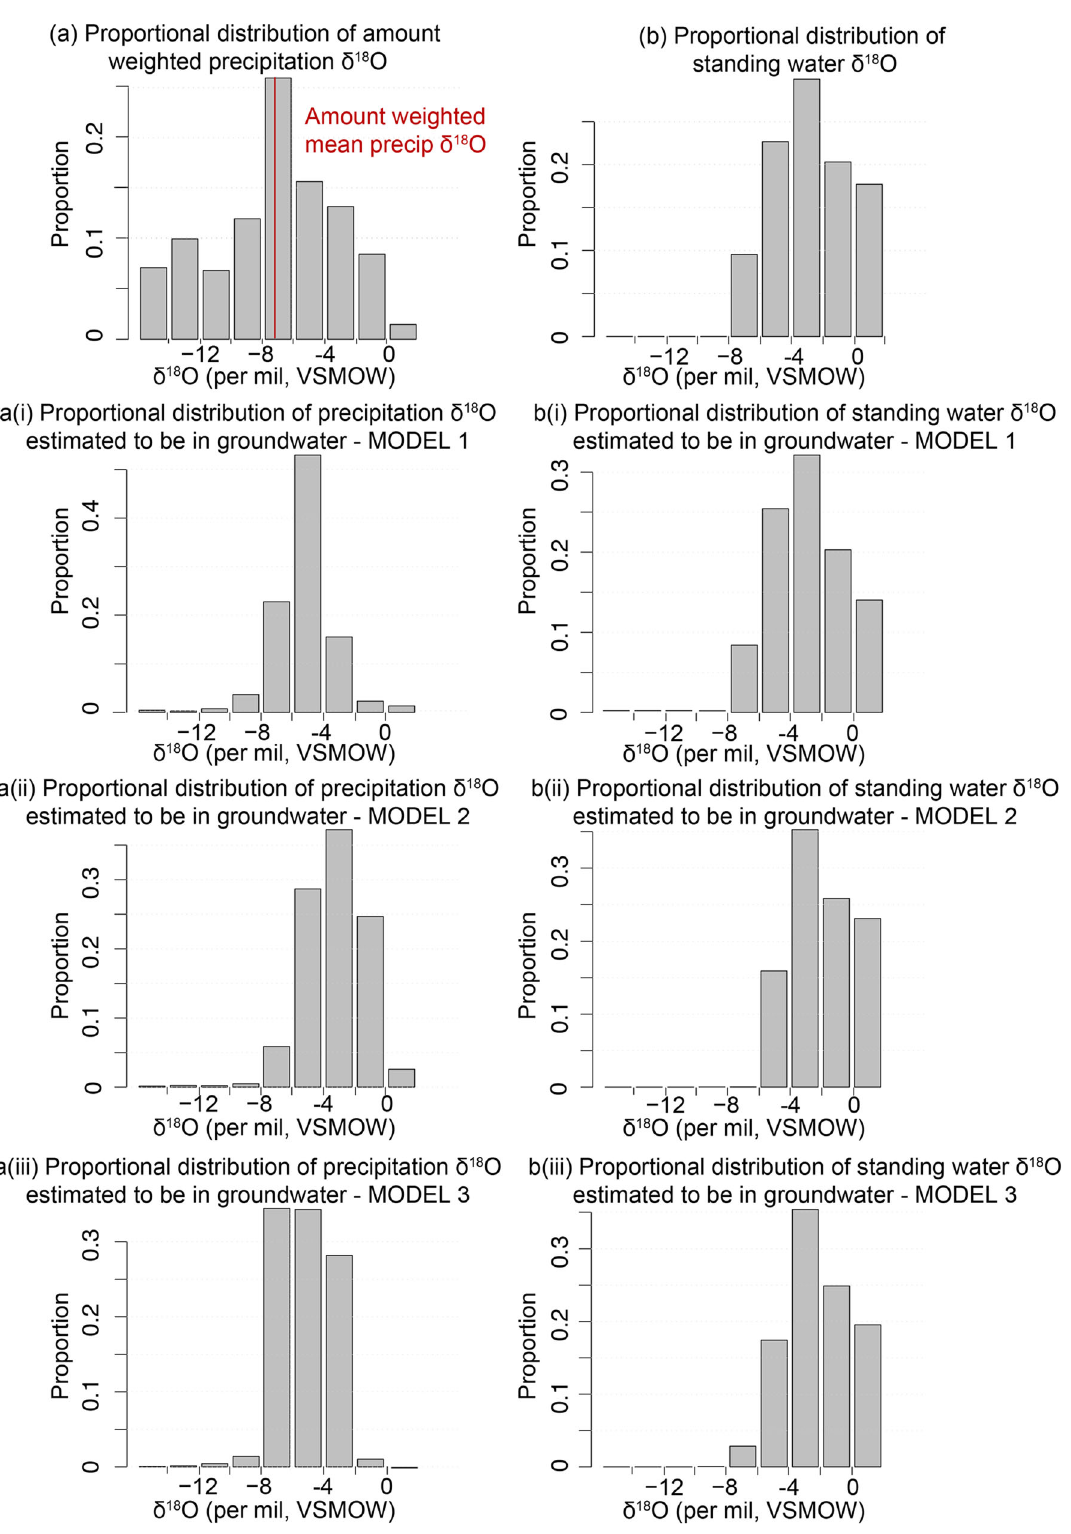
Fig. 8 Isotopic distribution of input and modeled precipitation and standing water in groundwater. Distribution of input ( a and b ) precipitation and standing water δ 18 O values. Distribution of modeled precipitation and standing water δ 18 O values in groundwater ( a (i) to b (iii)). The red line in panel a is the amount weighted mean precipitation δ 18 O